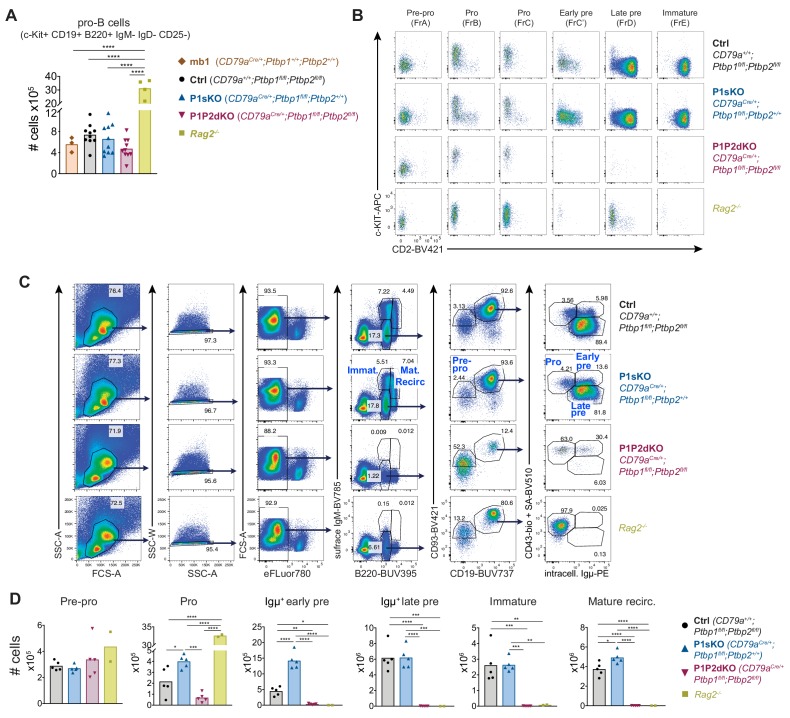
Absence of PTBP1 and PTBP2 blocks B cell development at the pro-B cell stage.(A) Numbers of Pro-B cells gated on dump (Gr-1, CD11b, Siglec-F, F4/80, NK1.1)-negative, IgD-, IgM-, B220+, CD19+, cKIT+, CD25- bone marrow cells. Data shown are from two independent experiments together. Each individual data point shows data from two femurs and two tibias from one mouse. (B) c-KIT and CD2 staining at different B cell developmental stages gated as shown in Figure 3A in mice of the indicated genotypes. (C) Cell surface and intracellular staining strategy to define B cell developmental stages using Igµ staining in bone marrow cells from mice of the indicated genotypes. Numbers shown are percentages of gated events. (D) Numbers of developing B cells in bone marrow from two femurs and two tibias identified as shown in C. Data shown are from one experiment. (A and D) Bars depict arithmetic means, each point represents data from an individual mouse and P-values were calculated by one-way ANOVA with Tukey's multiple comparisons test. Summary adjusted p value *<0.05, **<0.01, ***<0.001, ****<0.0001.